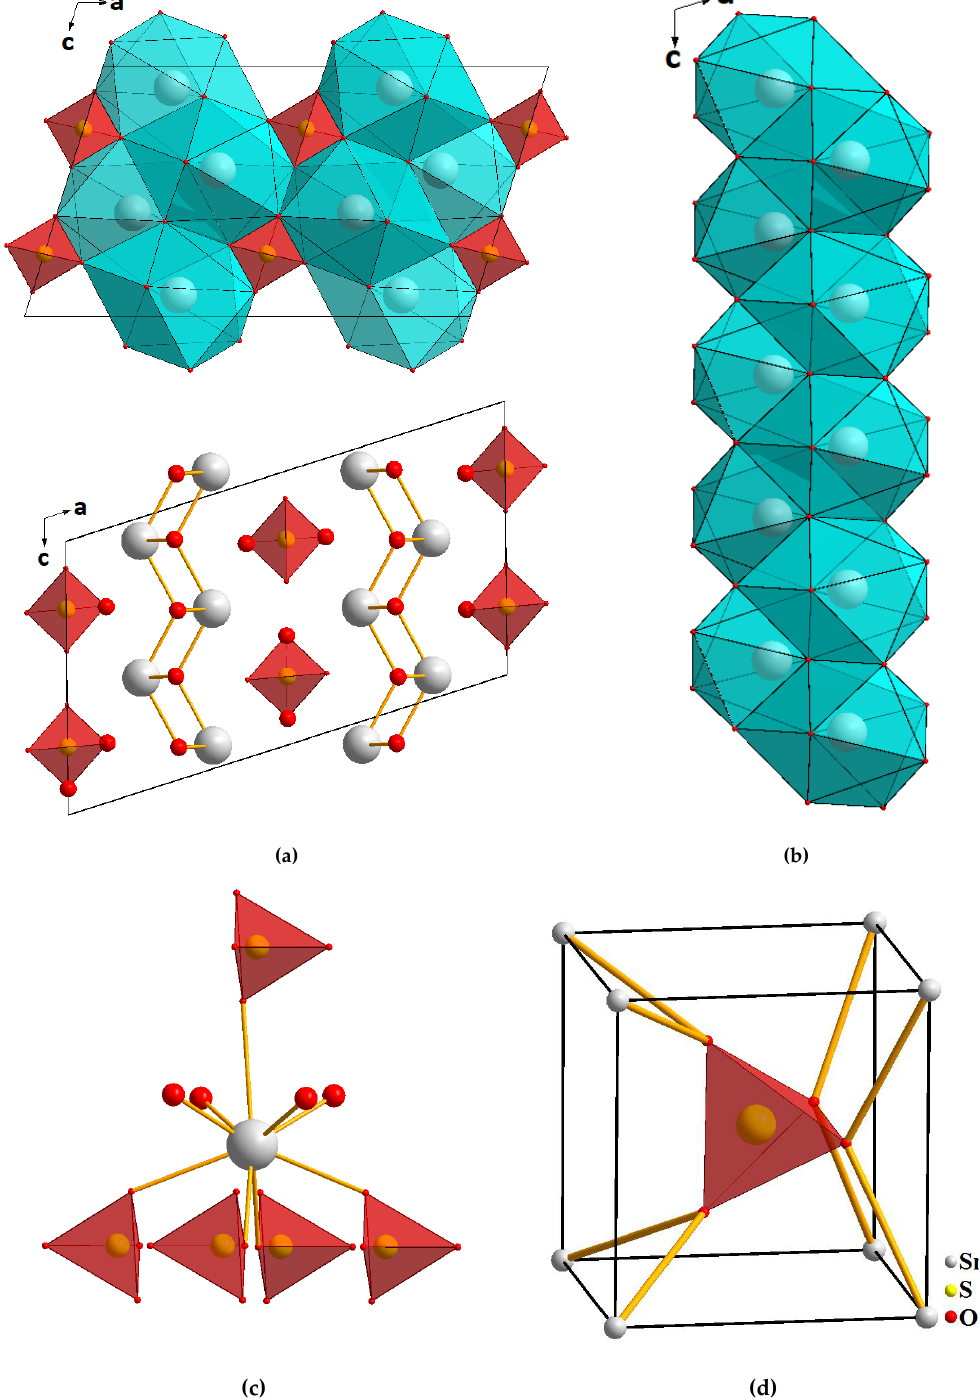
Figure 6. Projections of the Sm 2 O 2 SO 4 crystal structure ( a ), the structure of zigzag chains [SmO 9 ] n ( b ), coordination of samarium ( c ) and coordination of sulfate tetrahedra ( d ) in the structure.